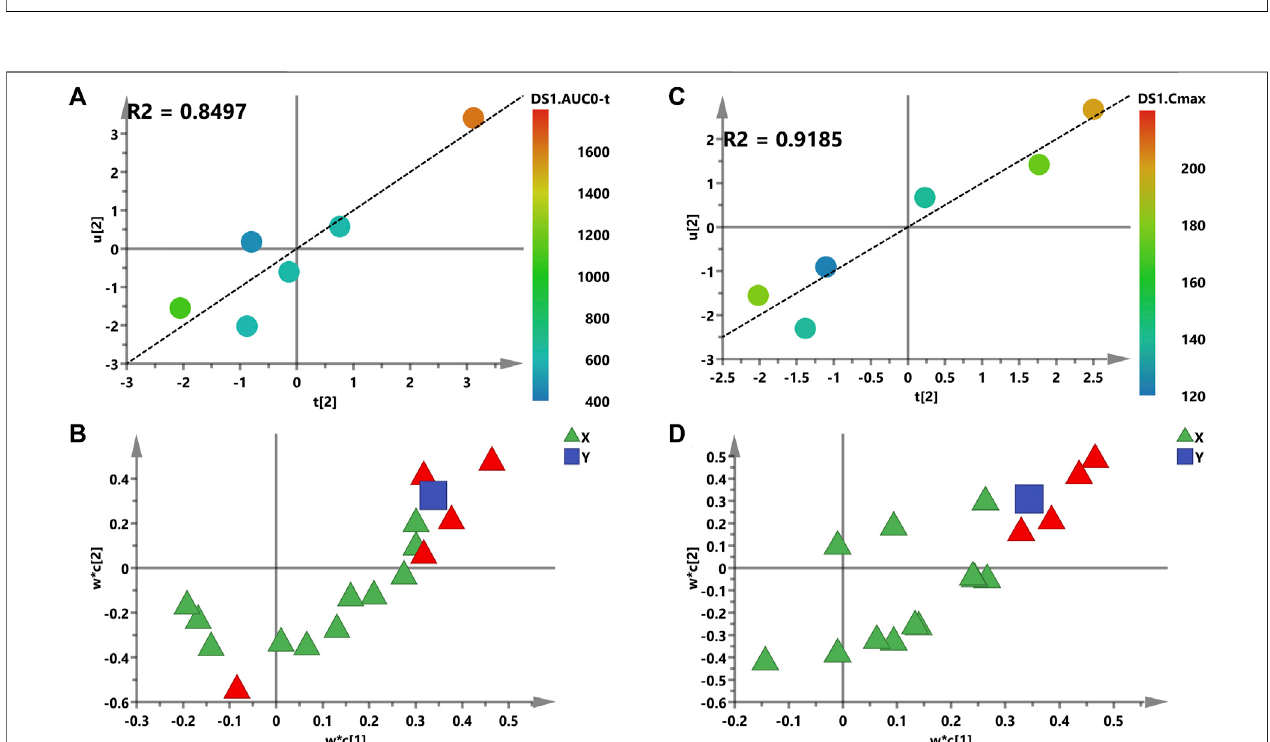
FIGURE 6 | PLS models of pre-dose metabolic characteristics for predicting PK parameters of Nuc. (A,C) Score plots for the variables of AUC and the C max prediction model; a color from blue to red represents the response variable from low to high. (B,D) Loading plots for AUC and the C max prediction model. The blue box represents the response variable; each triangle represents a metabolite, and the triangles in red represent the metabolites with VIP > 1.0.